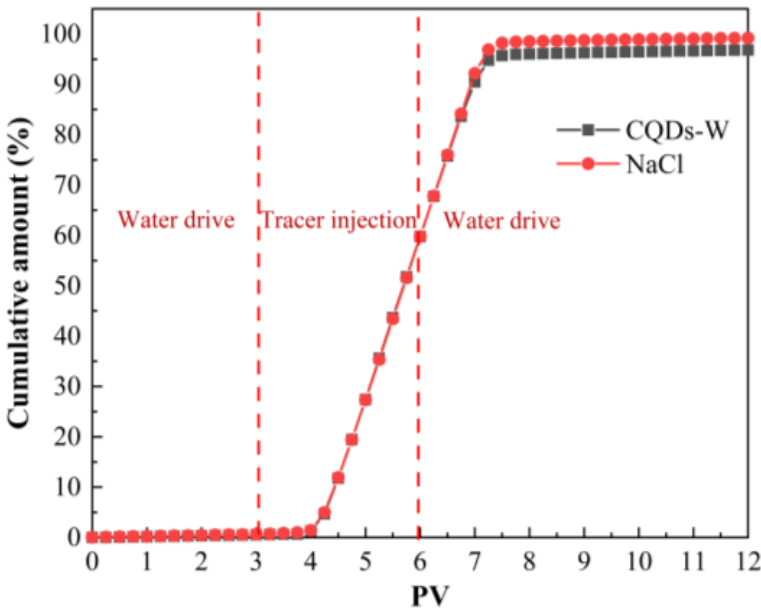
Figure 13. CQD-W cumulative volume versus injection volume.